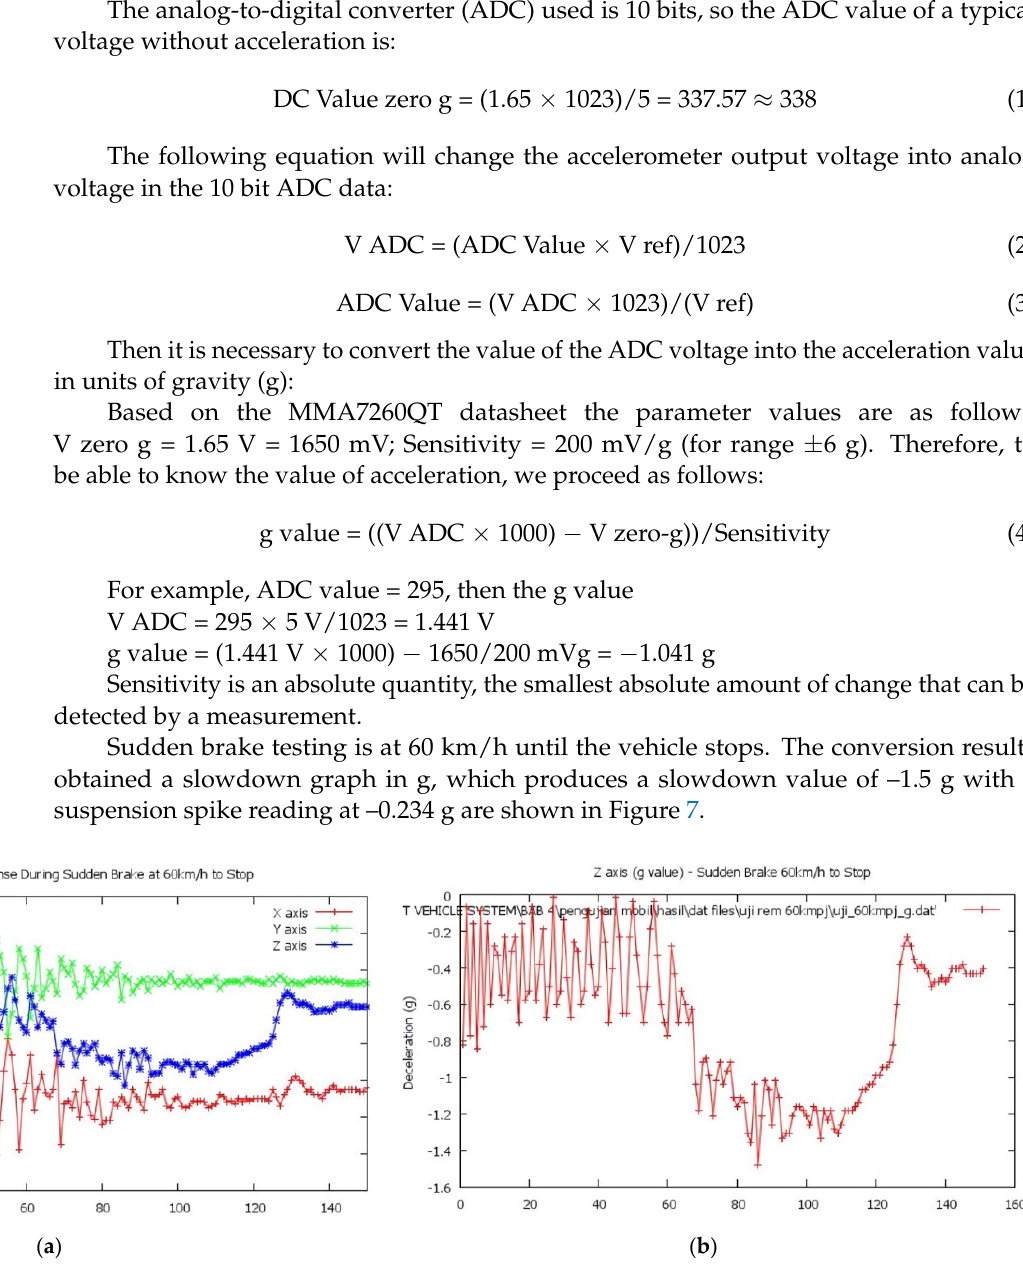
Figure 7. ( a ) Graph of sudden brake accelerometer; ( b ) acceleration value.